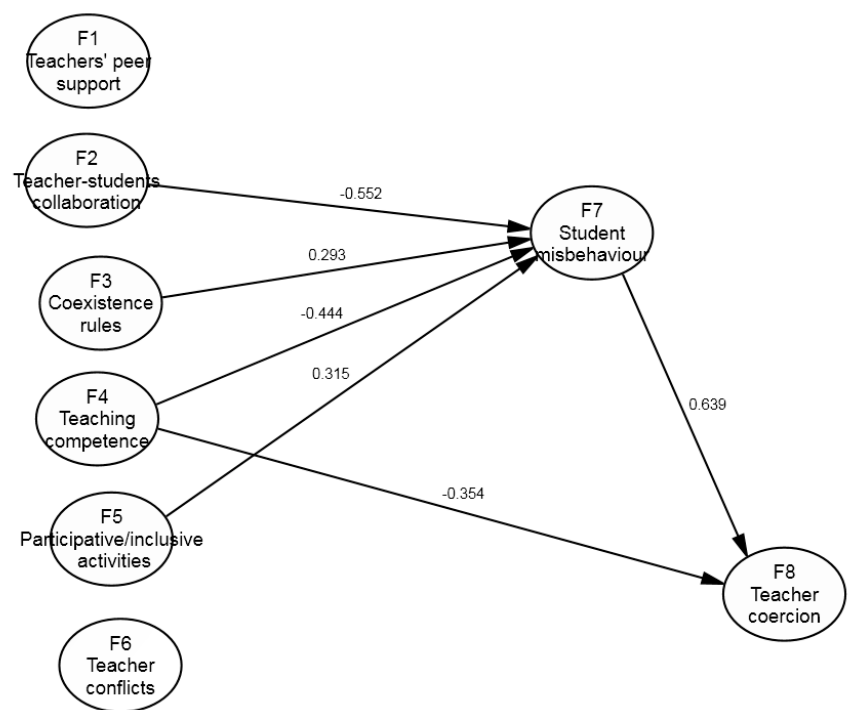
Figure 2. Results for primary school teachers.